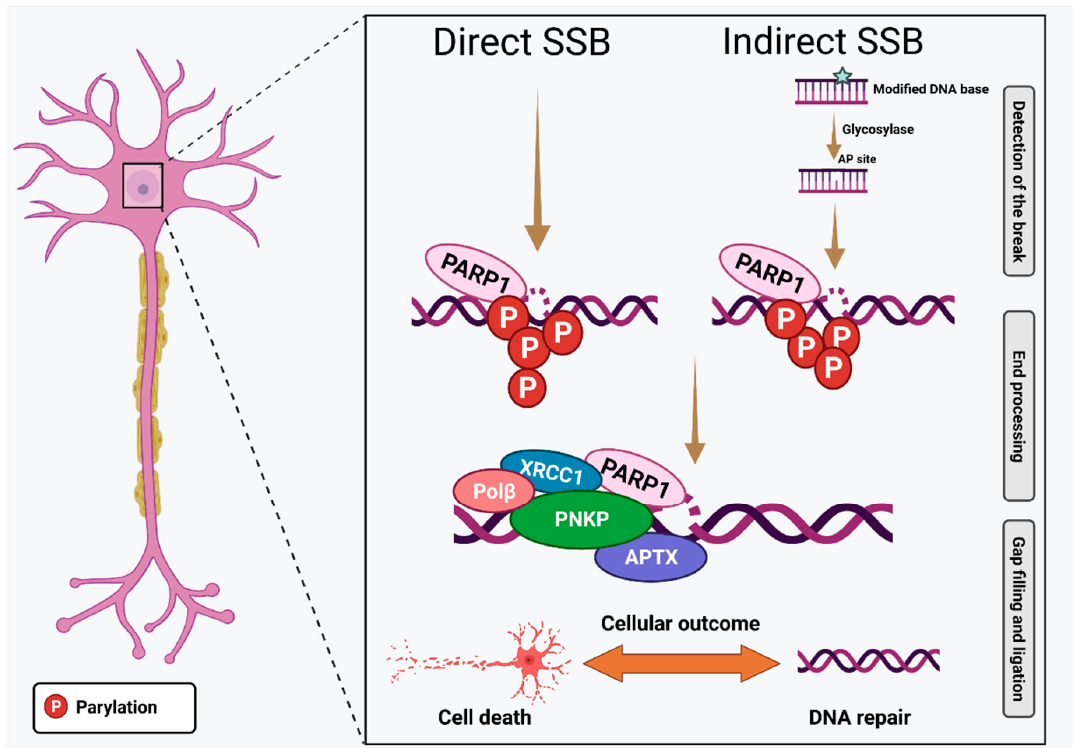
Figure 1. A simplified diagram illustrating the recognition of DNA single-strand breaks (SSBs) and the involvement of PARP1 in sensing the breaks. In neurons, SSBs can occur either by reactive oxygen species (ROS) that damage the deoxyribose sugar backbone (direct SSB), or by the action of enzymes that recognise and remove the modified DNA bases by oxidation, deamination, alkylation, and hydrolysis (indirect SSB). Excision of the damaged base is followed by PARP1 binding which then acts on itself, resulting in the addition of long branching chains of poly (ADP-ribose) (parylation). After detection of the DNA damage, X-ray repair cross complementing protein 1 (XRCC1) recruits several key proteins needed for broken DNA end processing and DNA ligation. This includes DNA polymerase β (POL β ), polynucleotide kinase phosphatase (PNKP), and aprataxin (APTX), which resolve the abnormal 5 ′ or 3 ′ ends, facilitating DNA repair, gap filling, and nick ligation. Hence, PARP1 plays an important role in the detection of SSBs [10,19].